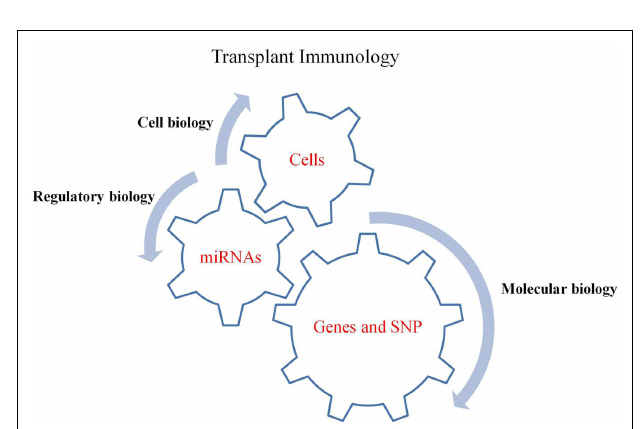
FIGURE 1 |The driving gears of GVHD . MiRNAs regulate gene expressions, chemokine and cytokine secretions while their expression is simultaneously affected by SNPs in mRNA (gene) targets.Thus, understanding the involvement of miRNAs in regulating gene expression, which ultimately affect the function of cells, will aid in our better understanding of the regulatory mechanisms involved in GVHD